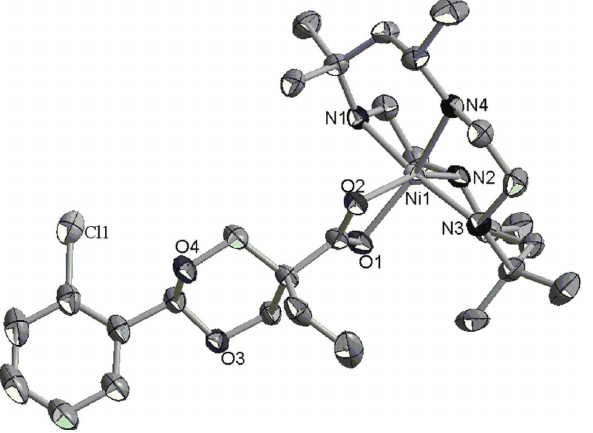
Table 1 contains crystallographic data and Table 2 contains the list of the atoms including atomic coordinates and dis- placement parameters.